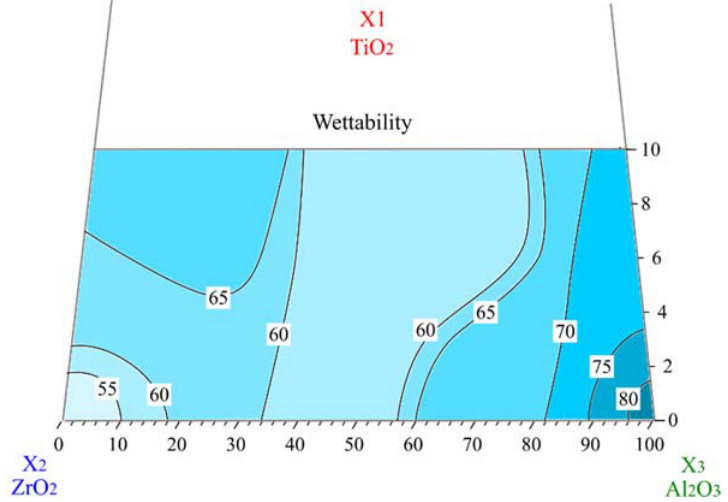
ff erent ceramics with water on a ternary TiO Figure 1. Contact angles of different ceramics with water on a ternary TiO 2 ‐ Al 2 O 3 ‐ ZrO 2 plot. Figure 1. Contact angles of di